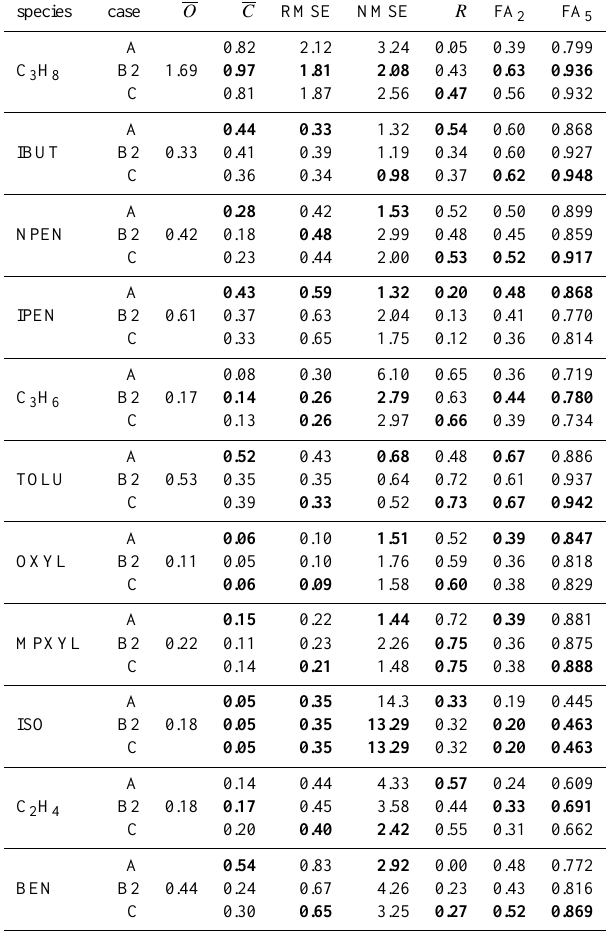
Table 9. Scores at the Kollumerwaard station (for the year 2006) from the comparison of the observations and the simulated con- centrations for three simulations: case A, case B2 and case C. The means and the RMSEs are in µgm − 3 . Bold numbers correspond to the best agreement with